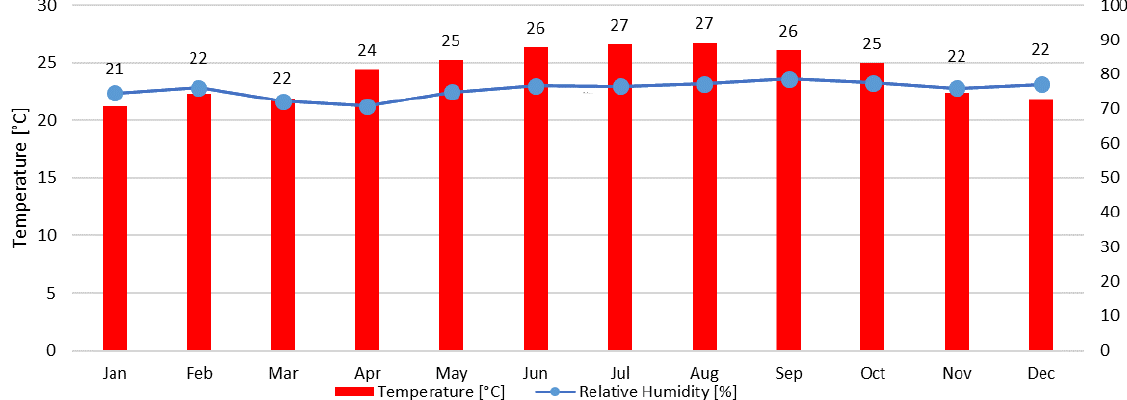
Figure 4. Havana, t and r.h. during the average year.